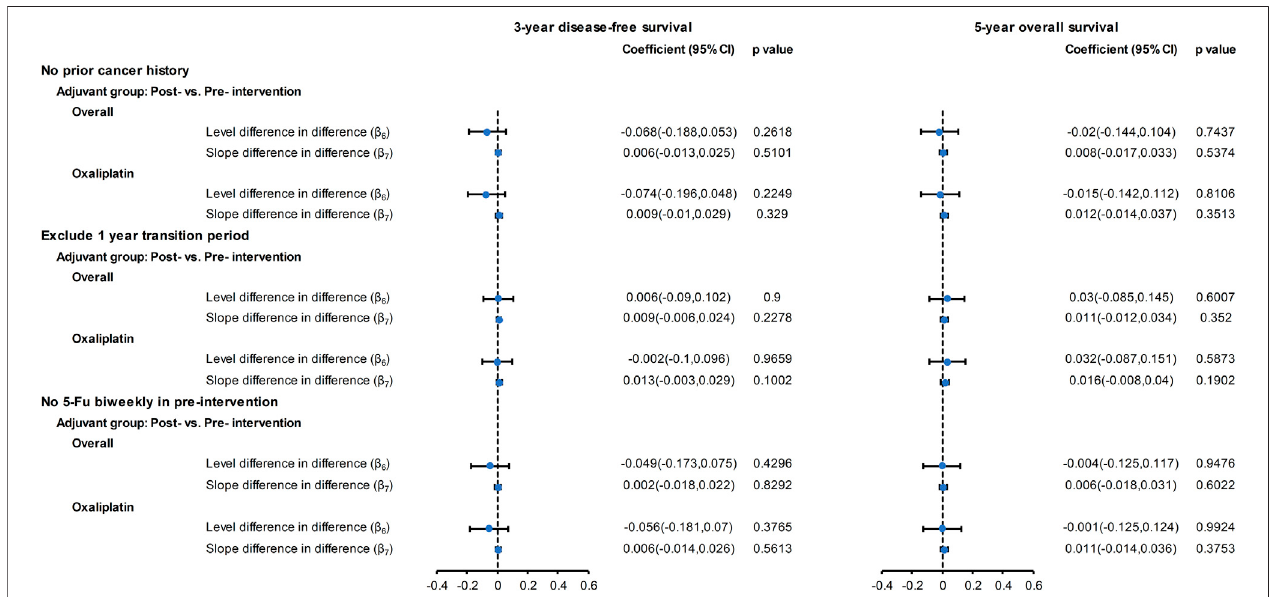
FIGURE4| Forestplotoftheregressioncoef fi cientsfortheCITSfortheoverallcohortandfortheoxaliplatincohortwithsensitivityanalyses:nopriorcancerhistory, excluding one-year transition period, excluding biweekly fl uoropyrimidine treatment before the intervention. Please refer to eMethod 1 in the Supplement for explanation of the regression coef fi cients ( β 6 , β 7